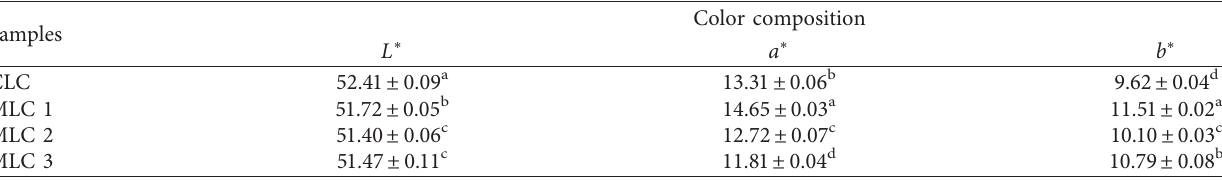
Table 11: Color composition of layer chicken meat obtained from a genuine supplier and three different markets.